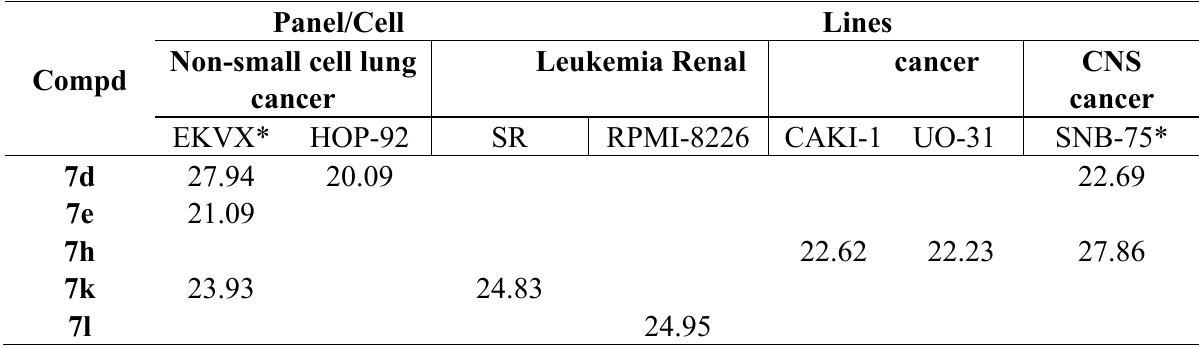
Table 3. In vitro cancer lines growth % inhibition of pyridazinones 7d,e,h,k,l . Panel/Cell Compd